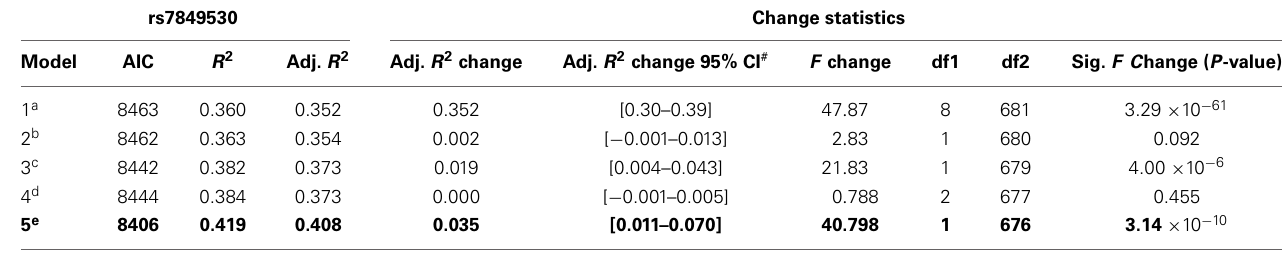
Table 3 | Hierarchical linear regression